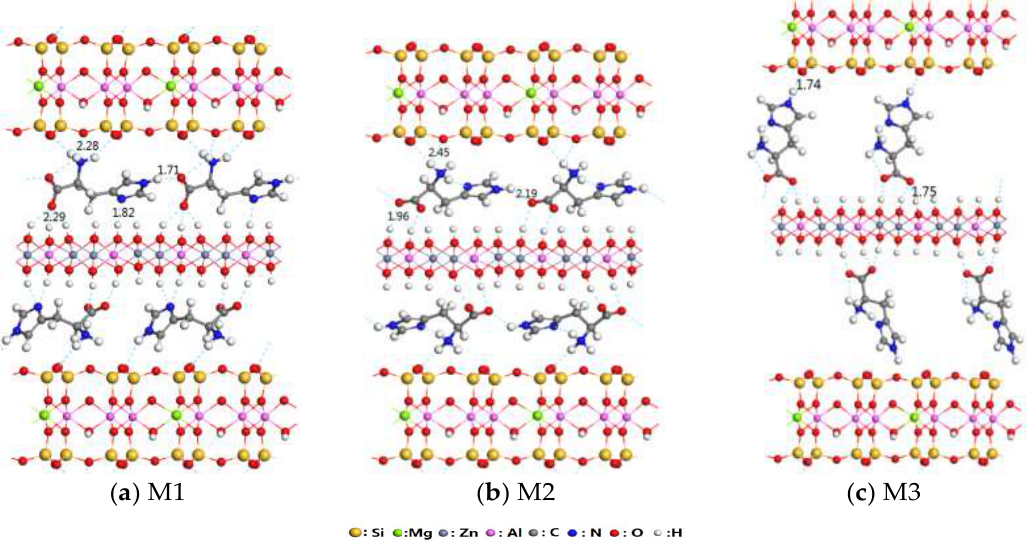
Figure 1. Three structures of His–LDHs–MMT (M1, M2, M3) (cell composition: a × 2 b × c ). Table 1. Lattice parameters and energy of M1, M2, and M3.